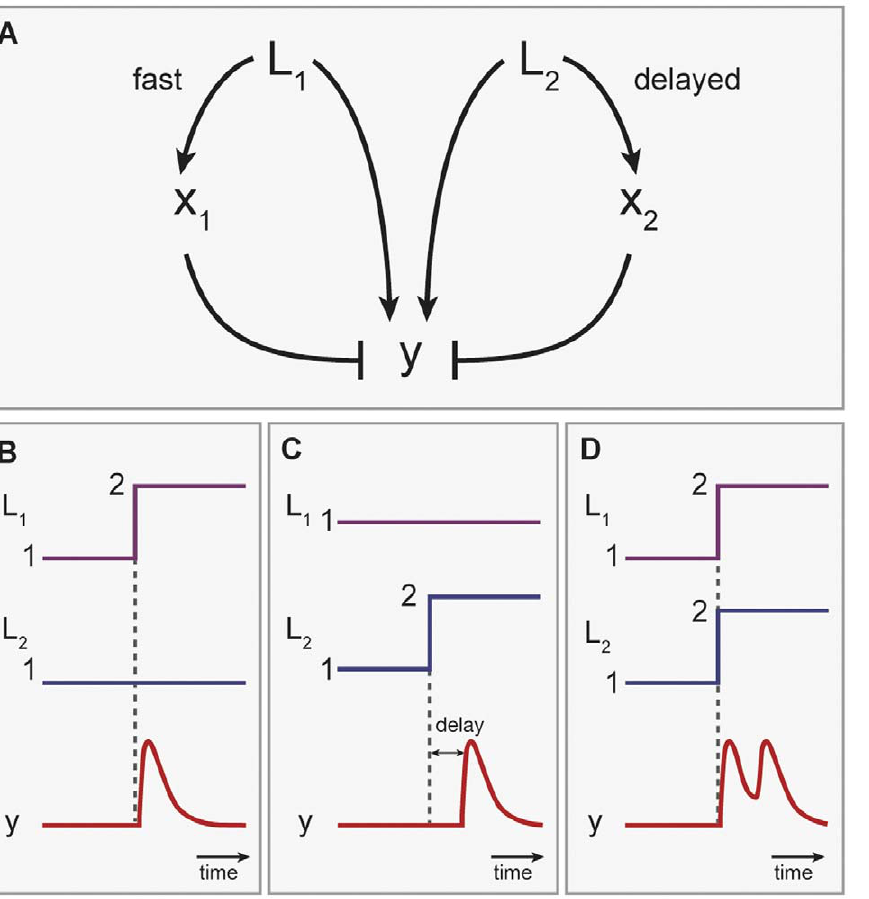
Figure 5. FCD systems with two internal layer components need not generally integrate multiple signals in a log-linear manner. (A) A model where each input interacts with its own internal layer component. In cases where one pathway has fast dynamics and the second pathway has a delay, the response to fold change steps in input one and two can be temporally separated. (B) Response to a step in L 1 is a fast pulse. (C) Response to a step in L 2 is a delayed pulse. (D) Response to simultaneous steps of L 1 and L 2 gives a two-pulse shape, and is thus not equivalent to any step of a single ligand.